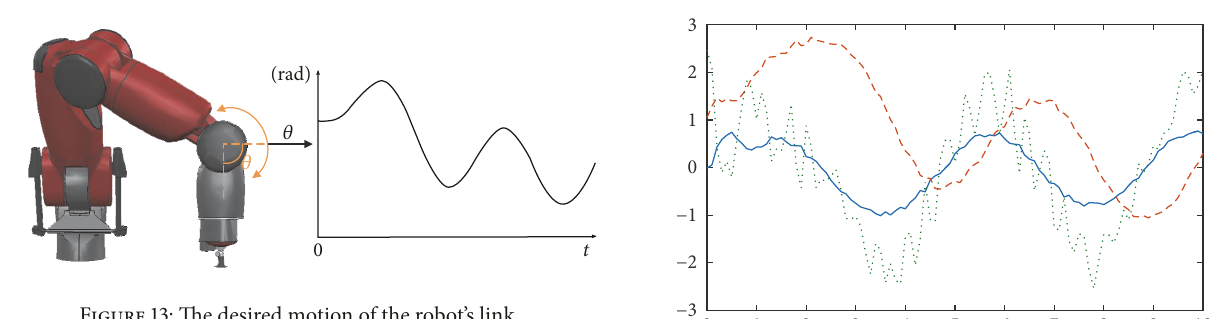
Figure 13: The desired motion of the robot’s link.